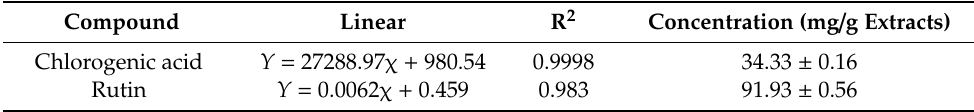
Table 5. Chlorogenic acid and Rutin contents of Dendropanax morbifera leaf extract under optimal extraction conditions. Data represent the mean ± S.E.M of three